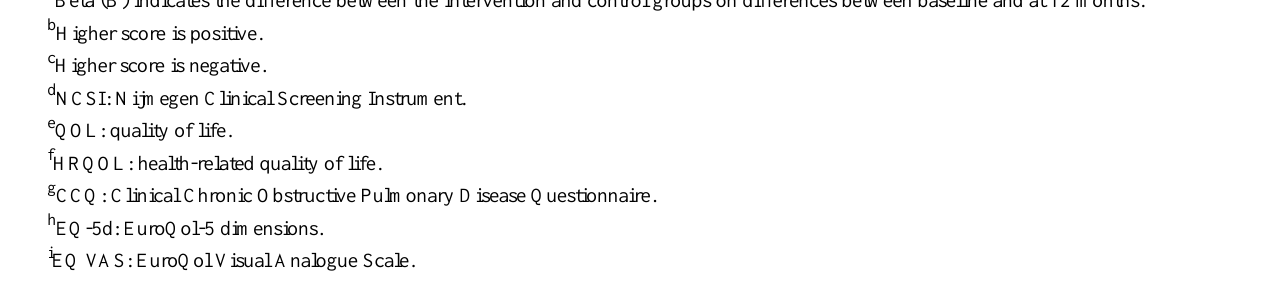
P valuePaper action plan control groupMobile health tool intervention